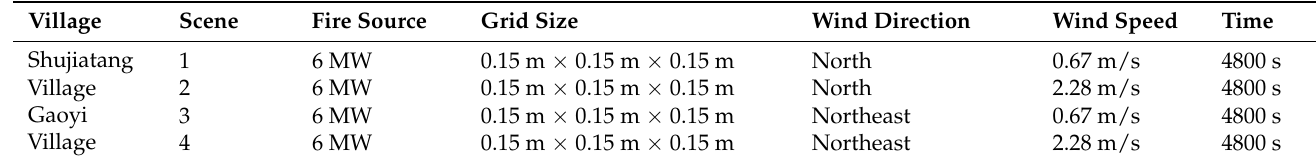
Table 2. Parameter settings for the fire simulation scenarios comparing village layouts.